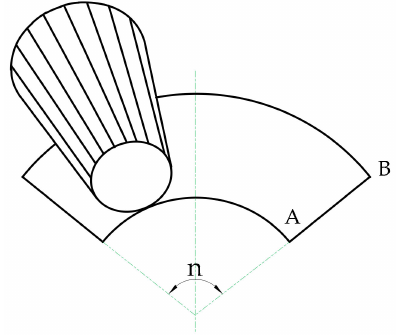
Figure 1. Unfolding the side of a truncated cone-shaped link.